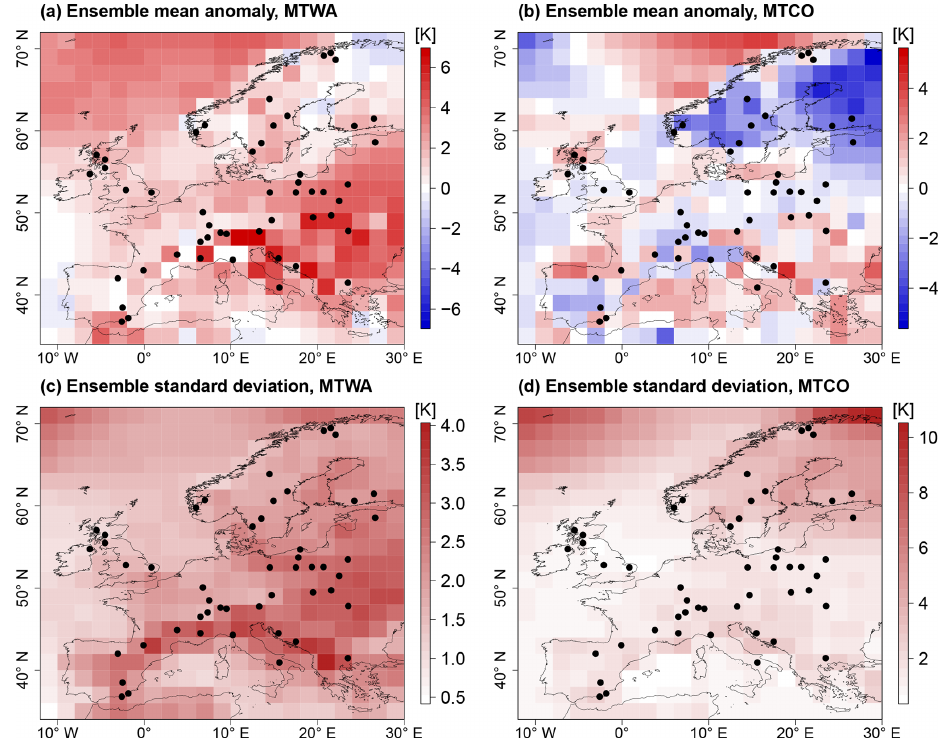
Figure 1. PMIP3 MH ensemble mean anomaly from CRU reference climatology for (a) MTWA and (b) MTCO. Ensemble spread as an empirical standard deviation of the ensemble members for (c) MTWA and (d) MTCO. Black dots depict proxy samples from Simonis et al. (2012). Table 1. Basic information on the PMIP3 climate simulations used to construct the process stage in the Bayesian framework (from https: //pmip3.lsce.ipsl.fr, last access: 30 May